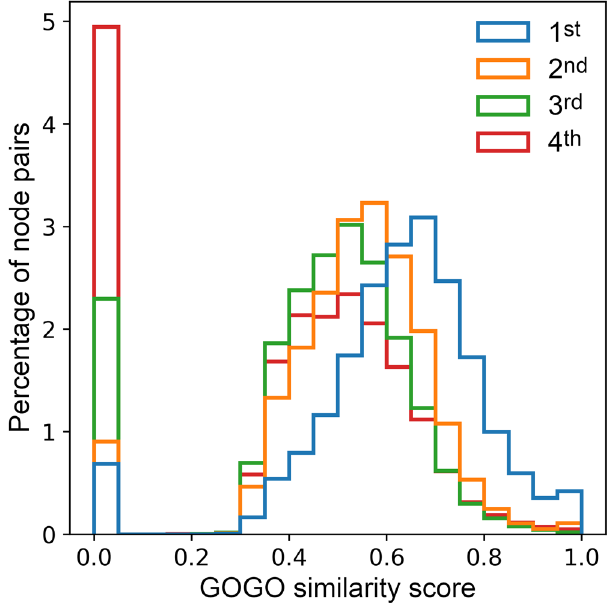
Fig. 2 Histogram of the pairwise GOGO similarity scores across the protein-protein interaction network. GOGO similarities are calculated using the biological process ontology for 1st, 2nd, 3rd, and 4th order neighbors in the